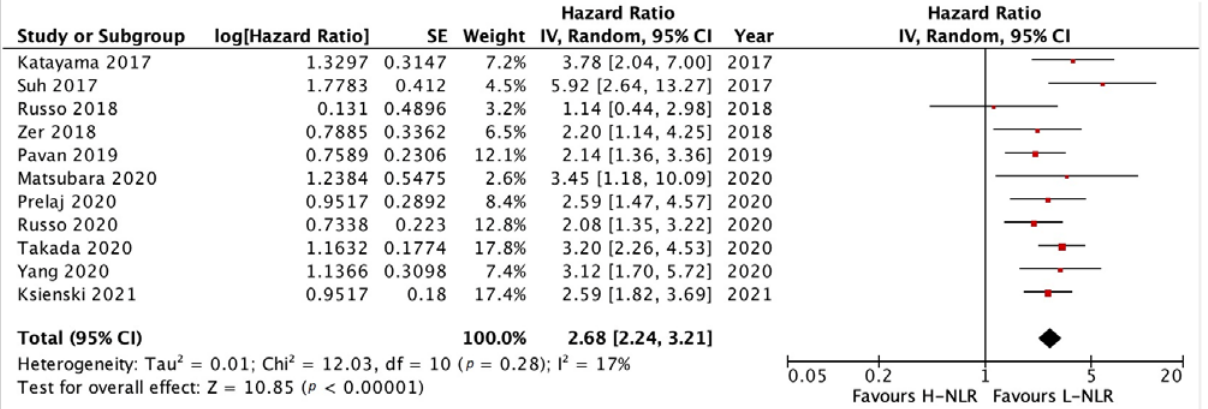
Figure 3. Forest plot H-NLR versus L-NLR to OS in patients treated with immunotherapy. Red dots represent study weights; the bivalve represent the overall effect.